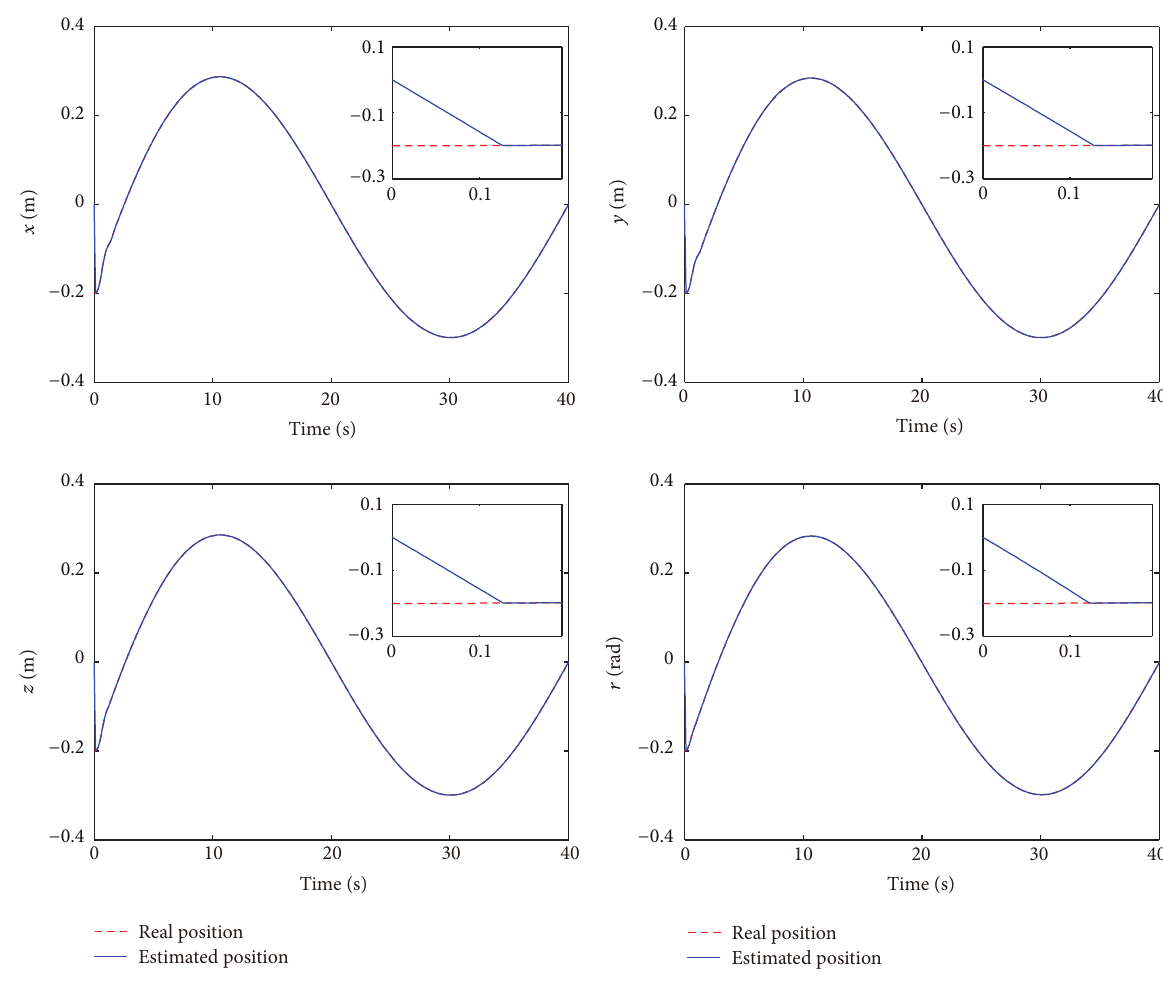
Figure 11: Estimated position and real position of output feedback IO-NTSMC with boundary